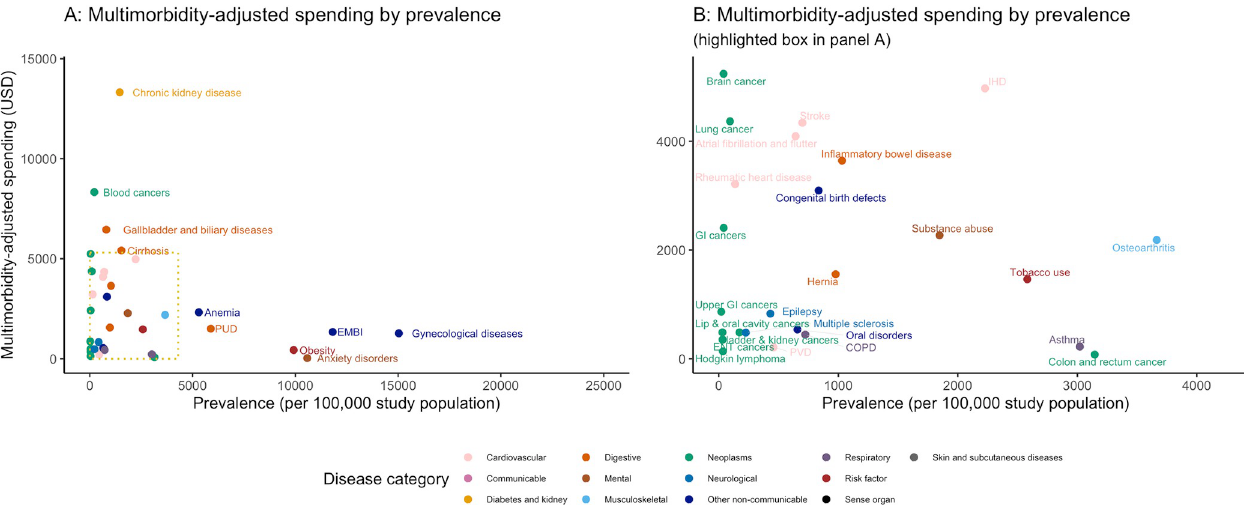
Fig 1. Multimorbidity-adjusted spending per treated case and observed prevalence for 63 chronic conditions. Abbreviations: ADHD, attention-deficit/ hyperactivity disorder; COPD, chronic obstructive pulmonary disease; EMBI, endocrine, metabolic, blood, and immune disorders; ENT, ear, nose, throat; GERD, gastroesophageal reflux disease; GI, gastrointestinal; hernia, inguinal, femoral, and abdominal hernia; IHD, ischemic heart disease; PHD, peripheral vascular disease; PUD, peptic ulcer disease; sarcoidosis, interstitial lung disease and pulmonary sarcoidosis; sense, sense organ diseases; skin, skin and subcutaneous